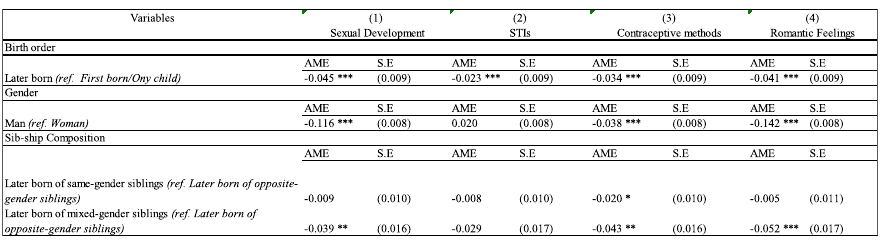
Table 5 : Fully Adjusted Average Marginal Effects for Predicted Probabilities